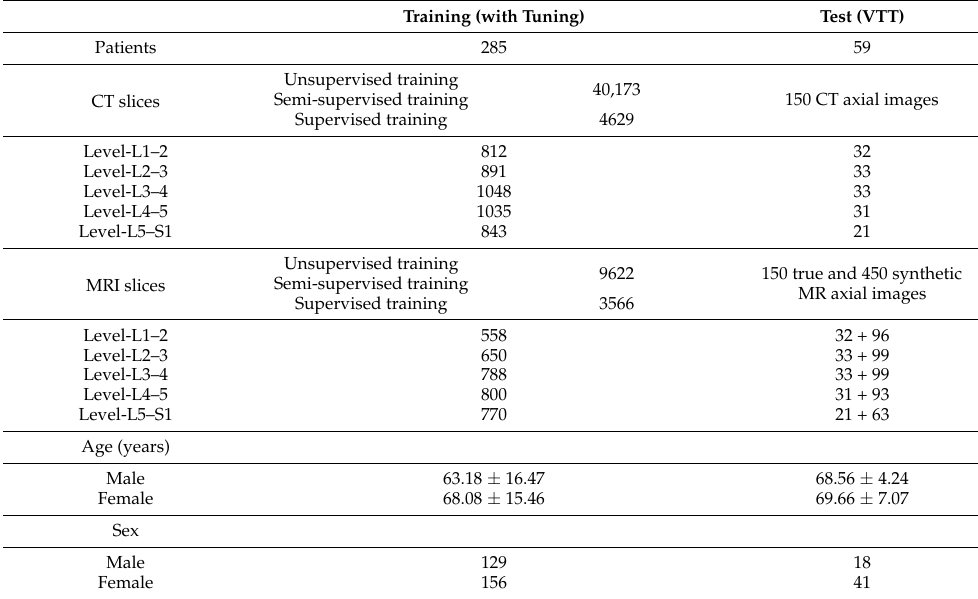
Table 1. Demographic characteristics of the study population by